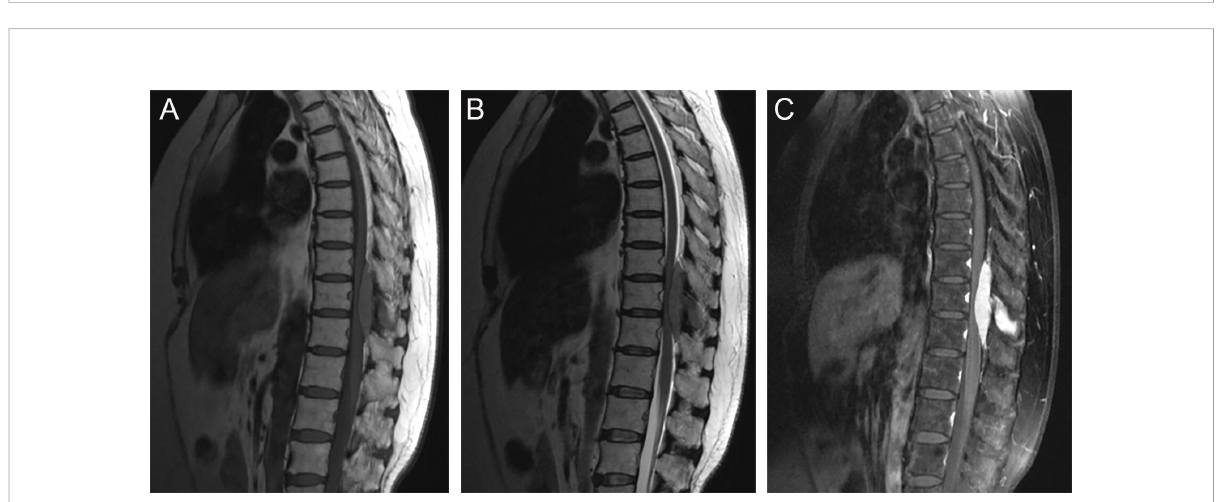
FIGURE 5 Sagittal MRI images showed a well-circumscribed extramedullary lesion with the destruction of adjacent bone, ranging from T10 to T12. (A) T1WI; (B) T2WI; (C) postcontrast